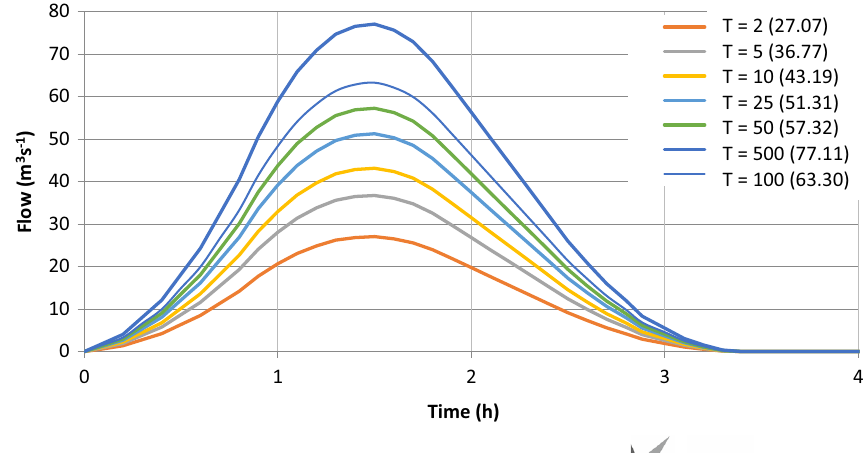
Fig. 5 Unit hydrograph of the sensitivity analysis accord- ing to the Recurrence Period (T = 1.30 h), Ribeirao do Suru watershed, Santana do